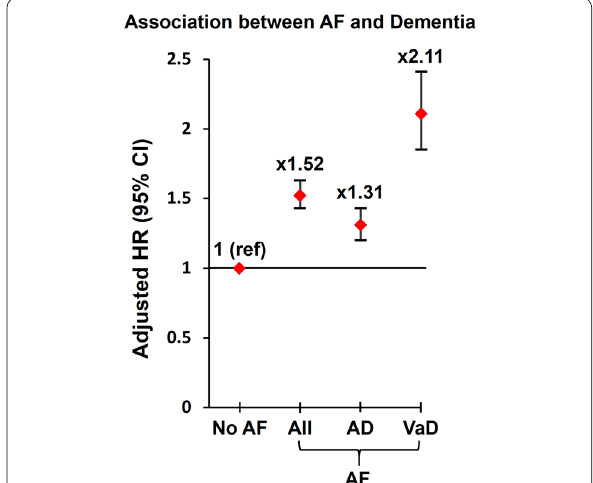
Fig. 1 Risk of dementia according to AF status. Modified from Kim et al. [8]. AD Alzheimer’s disease, AF atrial fibrillation, CI confidence interval, HR hazard ratio, VaD vascular